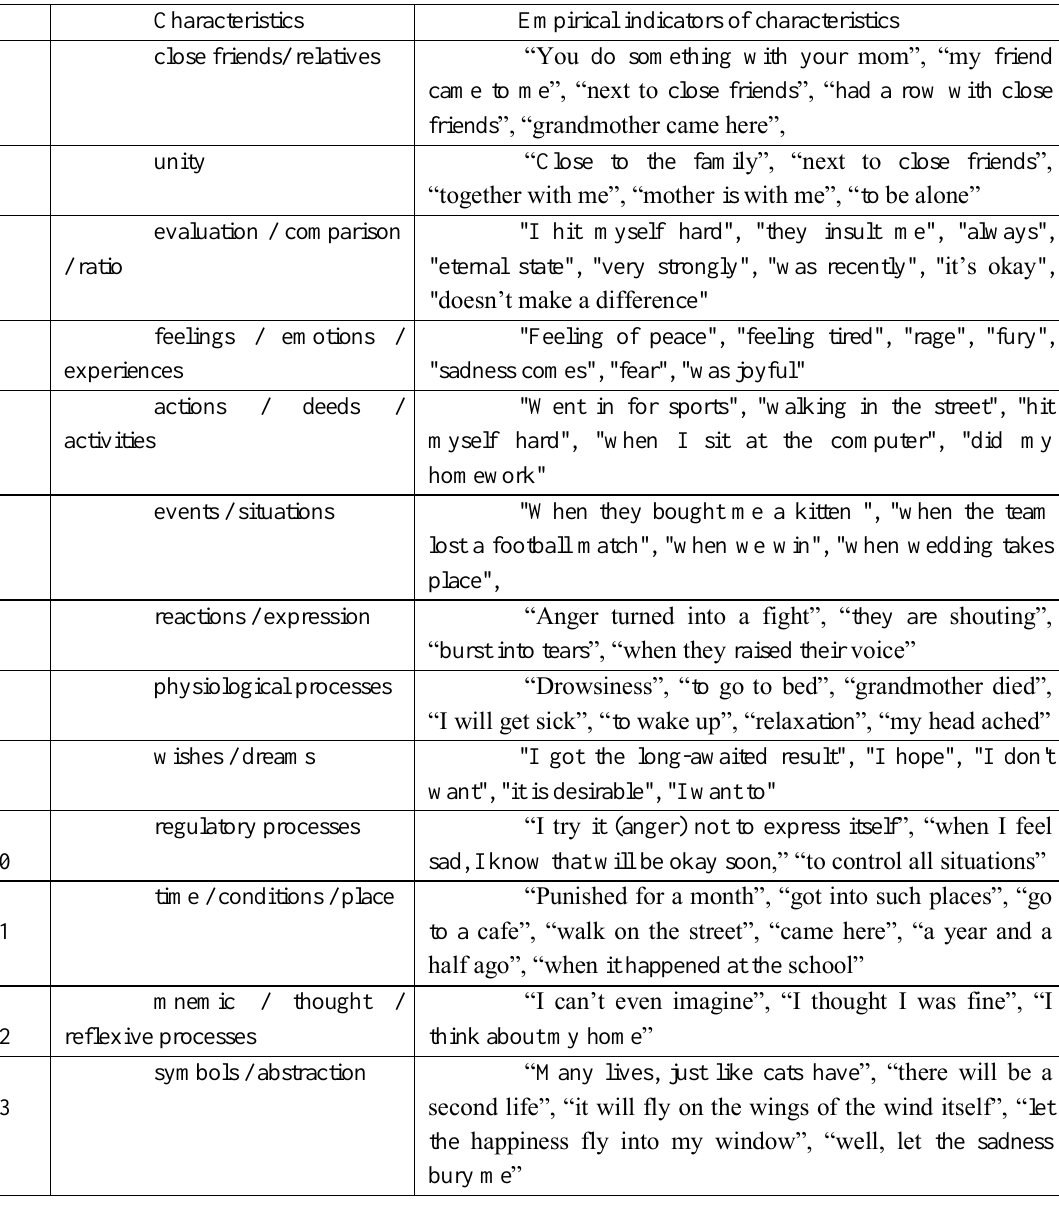
Table 1. Characteristics of the subjective experience of mental states and their empirical indicators Characteristics Empirical indicators of